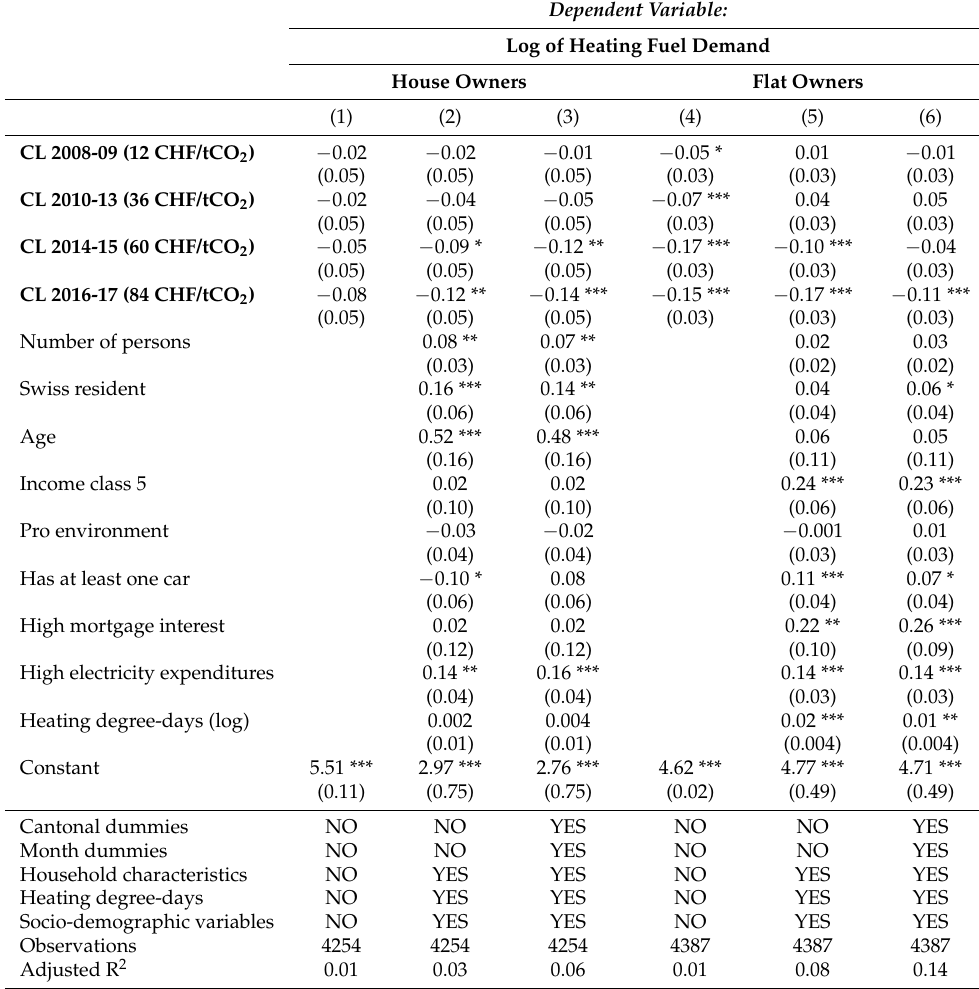
Table 2. Before-after